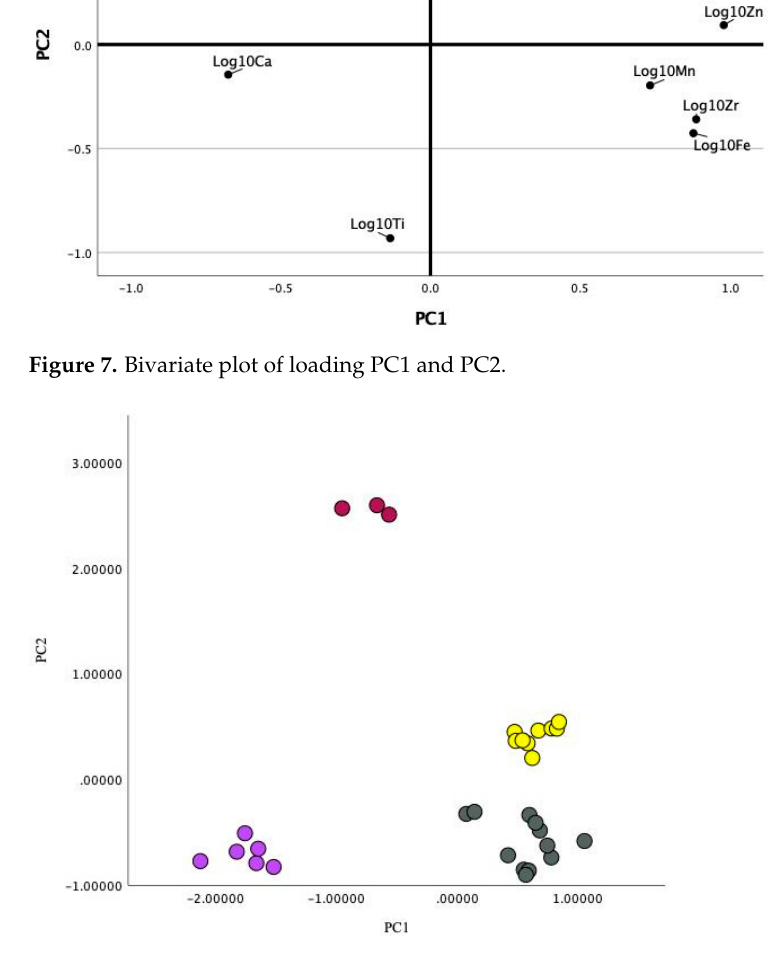
Figure 9. Rb vs. Pb scatterplot showing obsidian artefacts and Bingöl A geological samples.